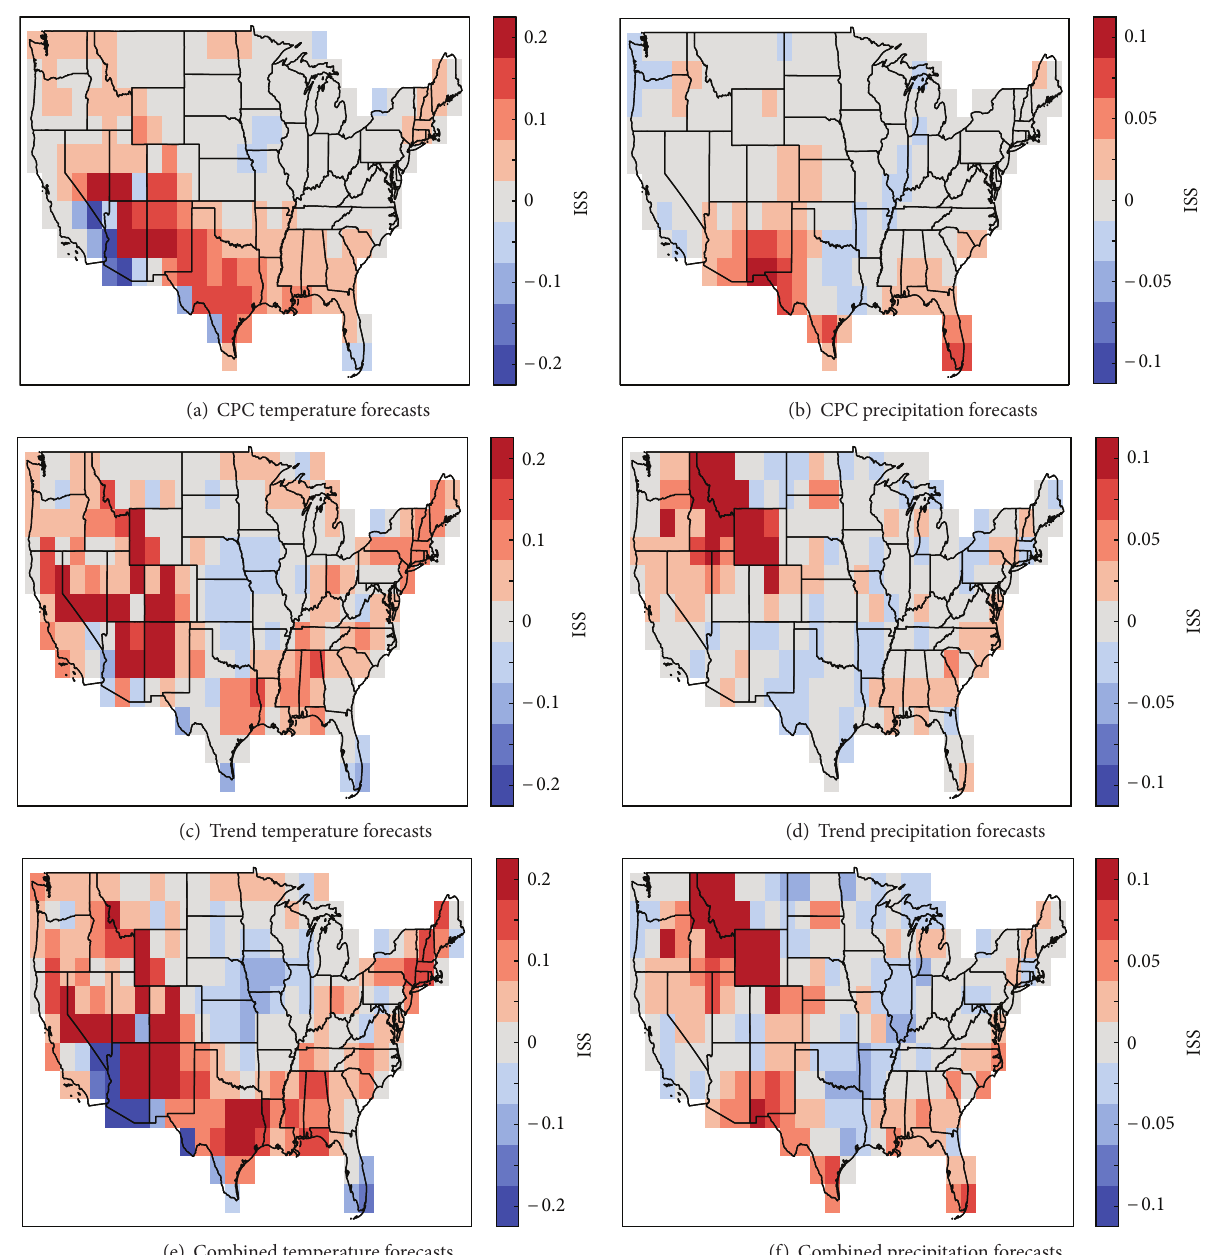
F 5: Mean information skill score for the CPC forecasts of (a) temperature and (b) precipitation. (c)-(d) Same, but for Trend forecast. (e)-(f) Same, but for Combined forecast.